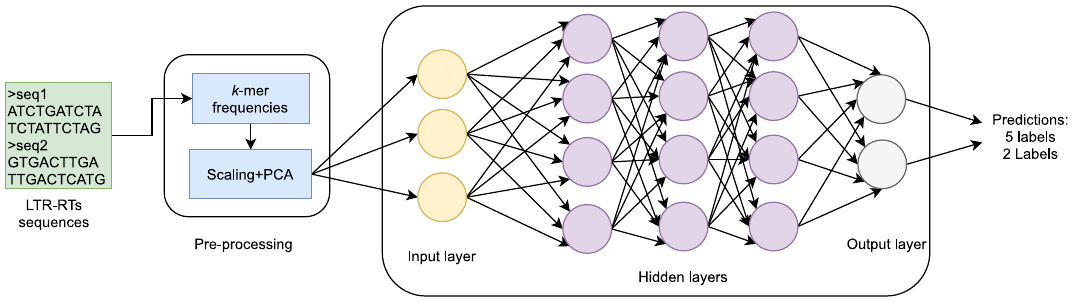
Figure 1: FNN architecture based on Nakano et al.